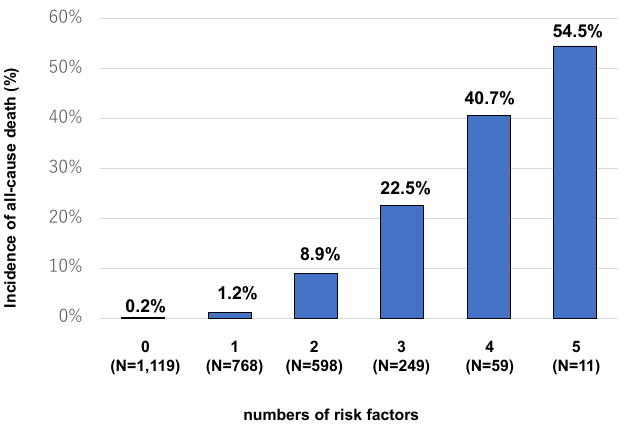
Figure 3. Incidences of all-cause mortality according to the number of potential mortality-associated risk factors, including age > 70 years, high D-dimer values on admission, heart disease, active cancer, more severe COVID-19 on admission, and onset of major bleeding during hospitalization. COVID- 19, novel coronavirus disease